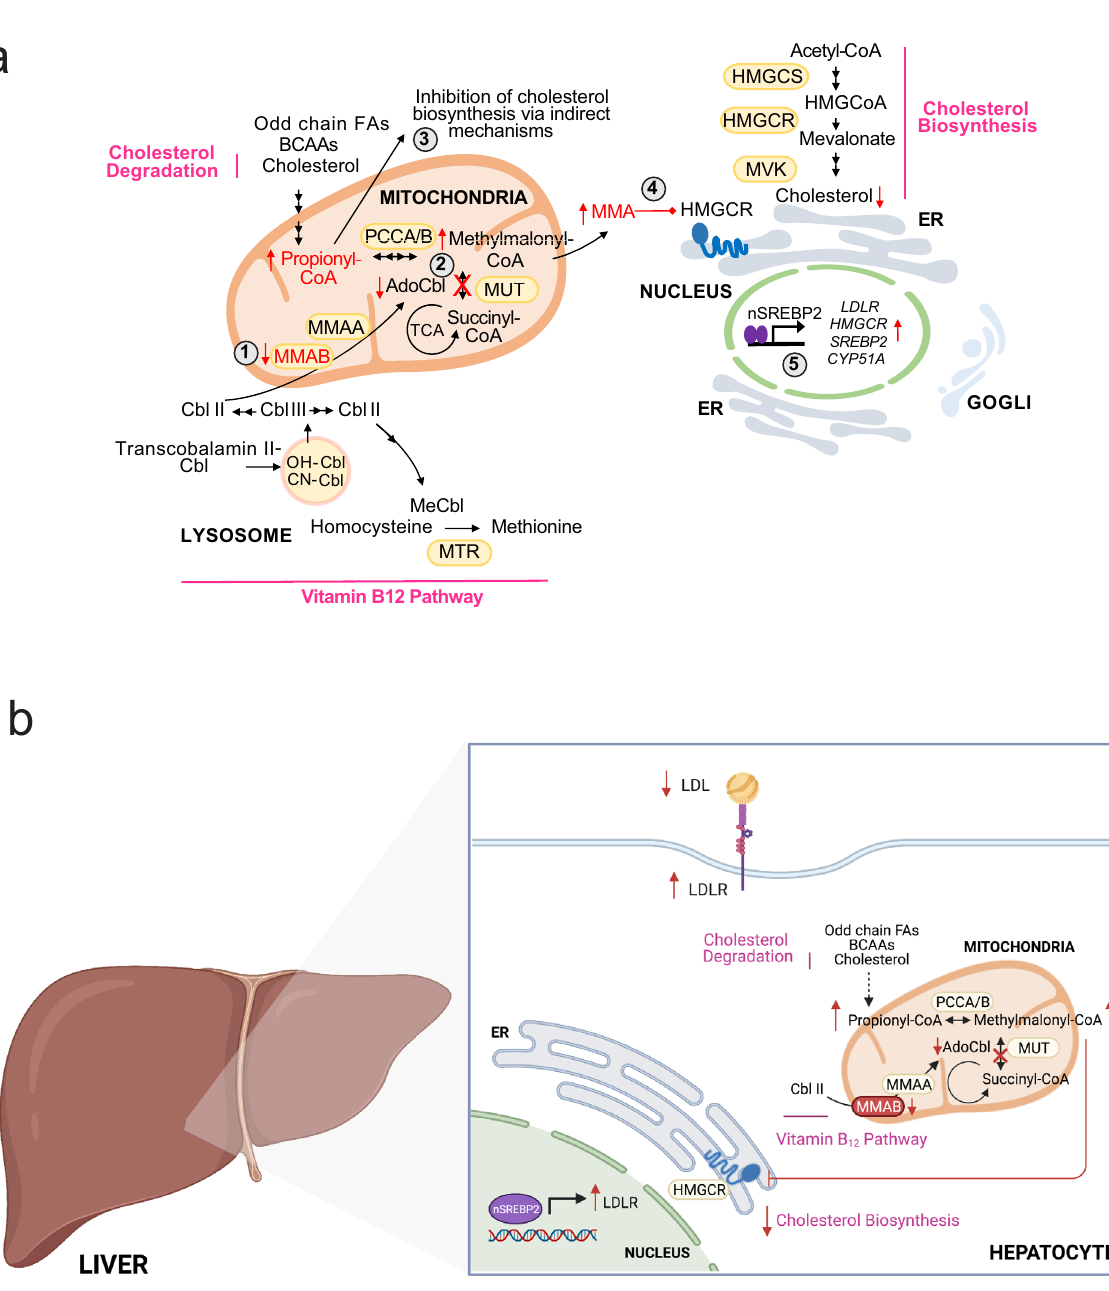
Fig. 8 Feedback control of cholesterol biosynthesis through modulation of adenosylcobalamin metabolism. a Schematic showing negative feedback regulation of cholesterol biosynthesis by MMAB. Loss of MMAB leads to reduced conversion of cob(I)alamin to AdoCbl ( 1 ), which impairs the function of methylmalonyl-CoA mutase (MUT) activity and results in the incomplete breakdown of certain amino acids, cholesterol and odd-chain fatty acids ( 2 ). This defect leads to the accumulation of propionic acid, which reduces cholesterol biosynthesis through indirect mechanisms ( 3 ), and the accumulation of methylmalonic acid, which reduces cholesterol biosynthesis by inhibiting HMGCR ( 4 ). Sterol depletion leads to the subsequent upregulation of SREBP2- mediated gene expression ( 5 ), thereby providing an additional control point by which cholesterol biosynthesis is regulated by its end product. BCAAs branched chain amino acids, FAs fatty acids, MMA methylmalonic acid. b Schematic showing the role of the adenosylcobalamin pathway in regulating hepatic LDLR expression and circulating LDL-C